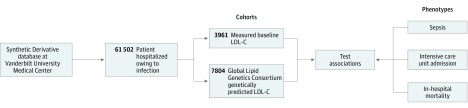
Overview of Clinical and Genetic ApproachesLDL-C indicates low-density lipoprotein cholesterol.